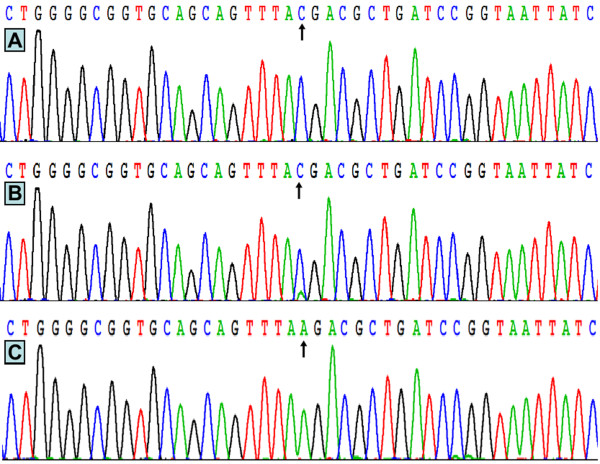
A part of the nucleotide sequence of theABCG8rs4148217 SNP. (A) CC genotype; (B) CA genotype; (C) AA genotype.